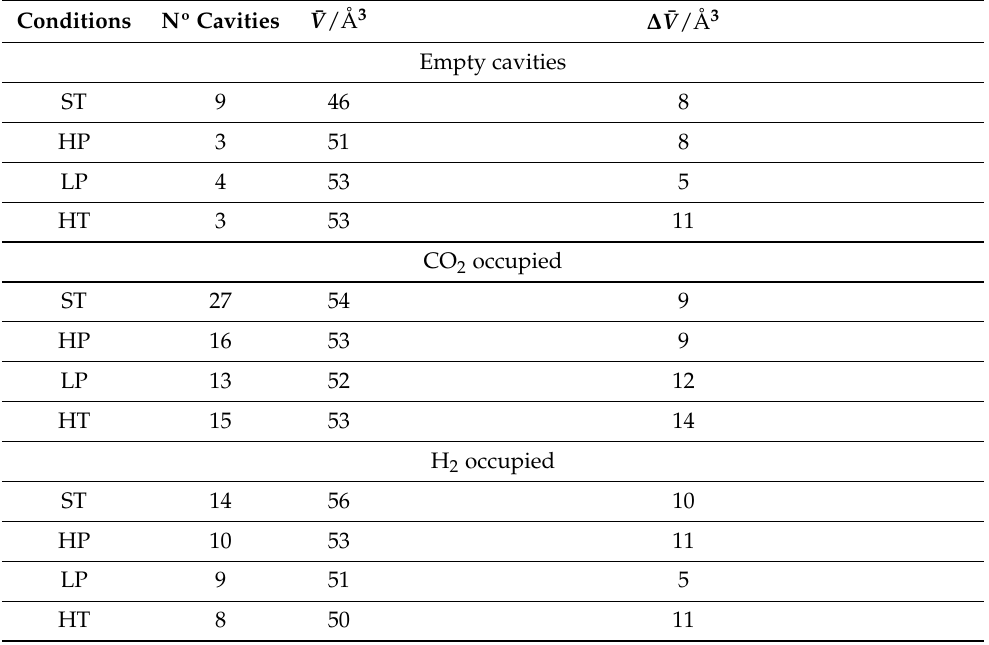
Table 6. Estimation of average C-111 cavity inner volume ( ¯ V / Å 3 ), for each set of simulations performed, and the corresponding standard deviations ( ∆ ¯ V / Å 3